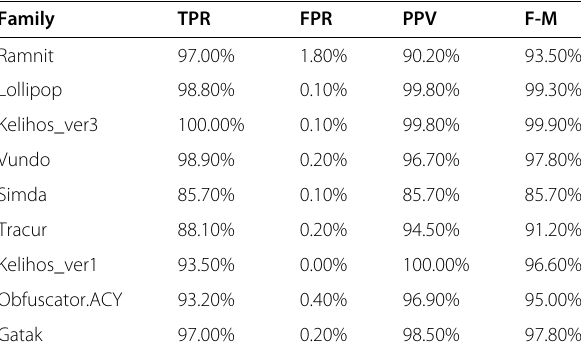
Table 2 Performance for malware categorization with the Word2Vec-based TCN structure